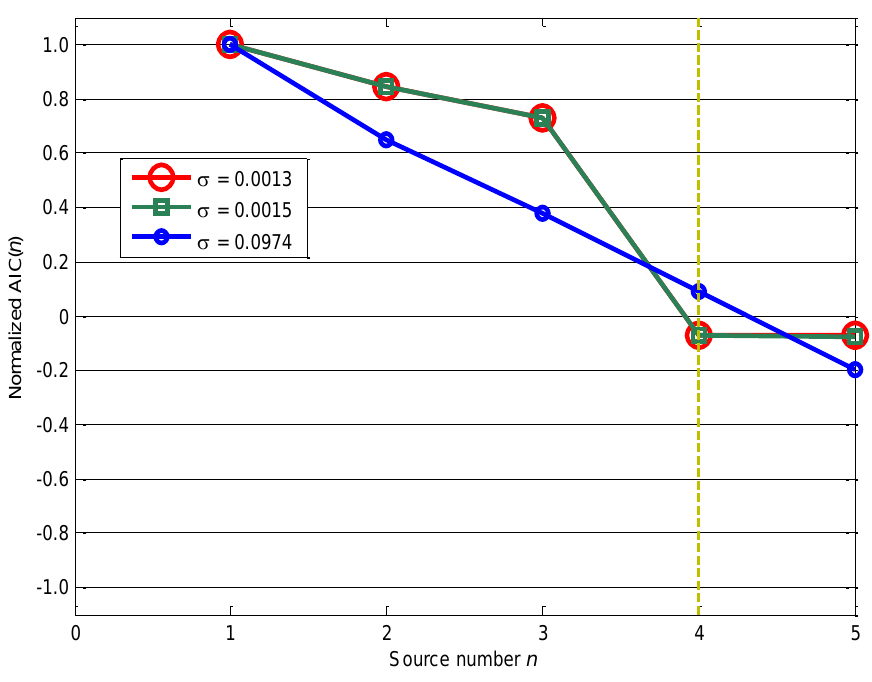
Figure 6. Source number estimation by